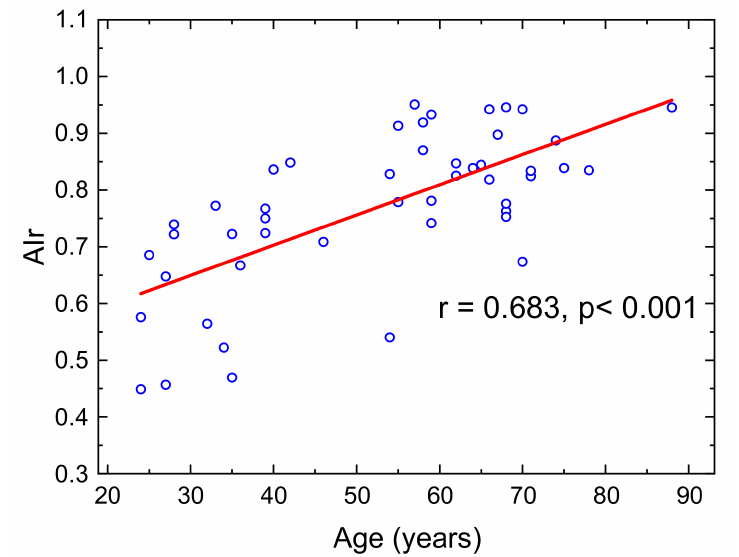
Figure 10. AIr with respect to ages of 48